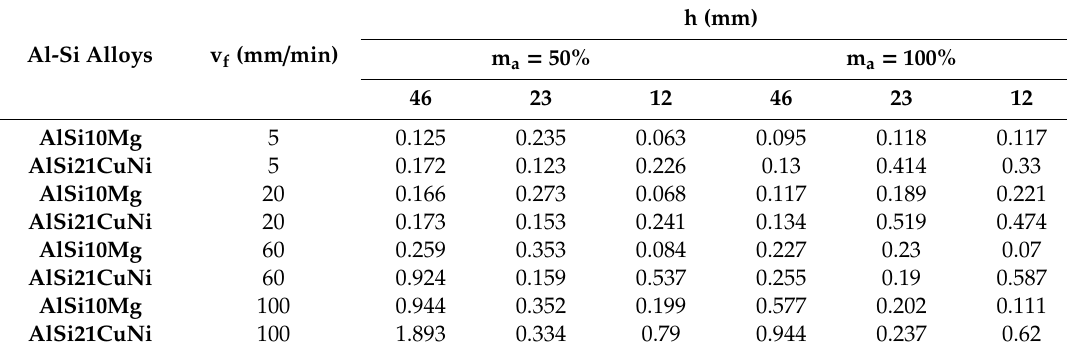
Table 4. Quantified surface irregularities after AWJ